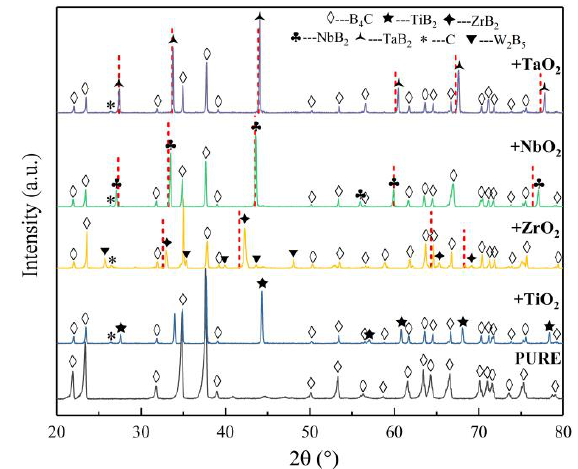
Figure 2. XRD pattern analysis for different sintered samples.